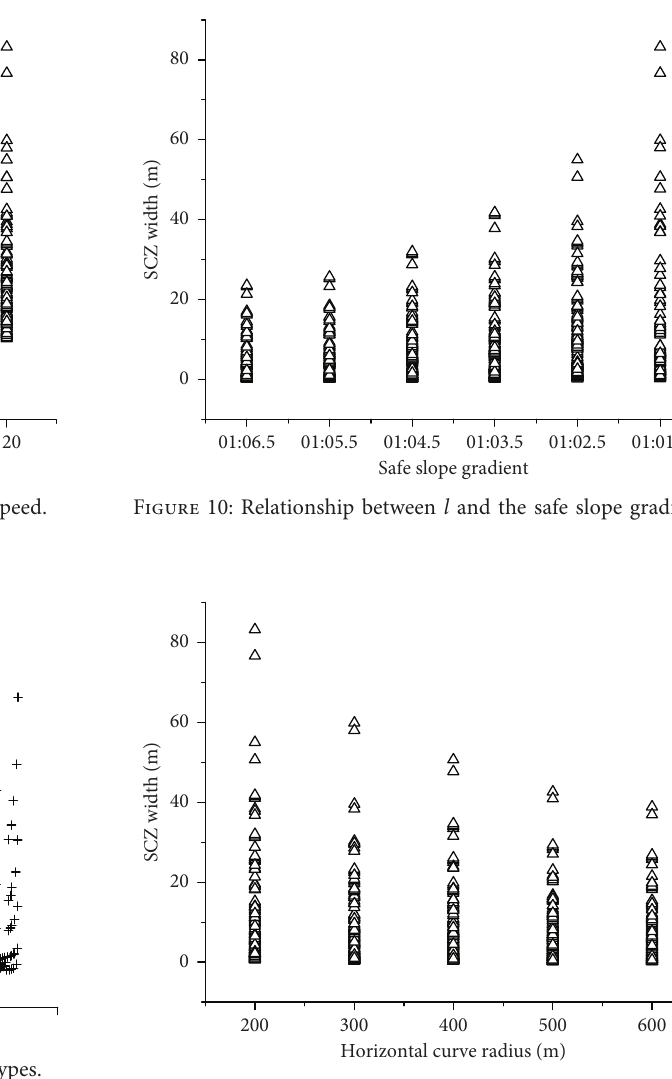
Figure 11: Relationship between l and the horizontal curve